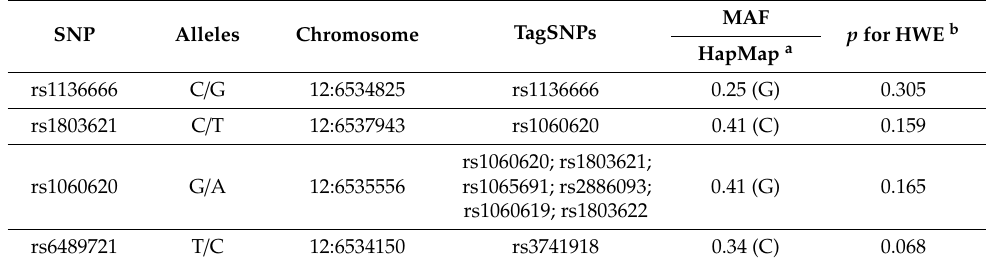
Table 3. Selected SNPs and Hardy-Weinberg test.